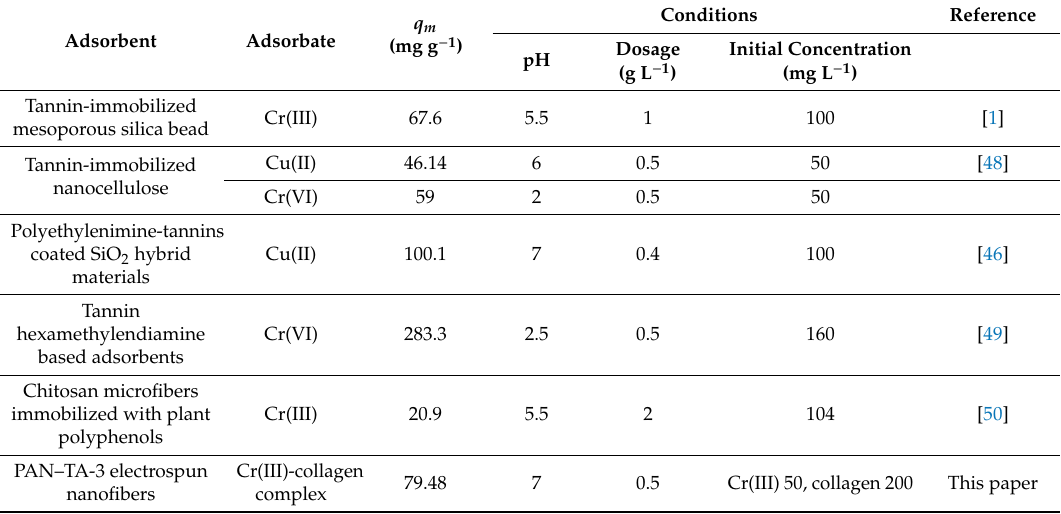
Table 3. Comparison of adsorption capacity of metal ions by some tannin-based